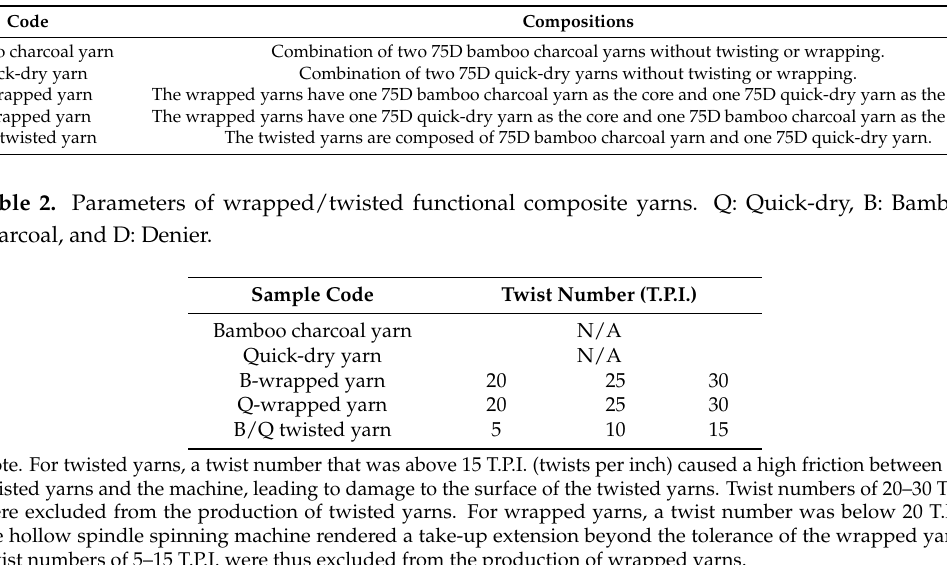
Table 3. Specification of functional composite yarns. Q: Quick-dry, B: Bamboo charcoal, and D: Denier. Twist Number Yarn Type